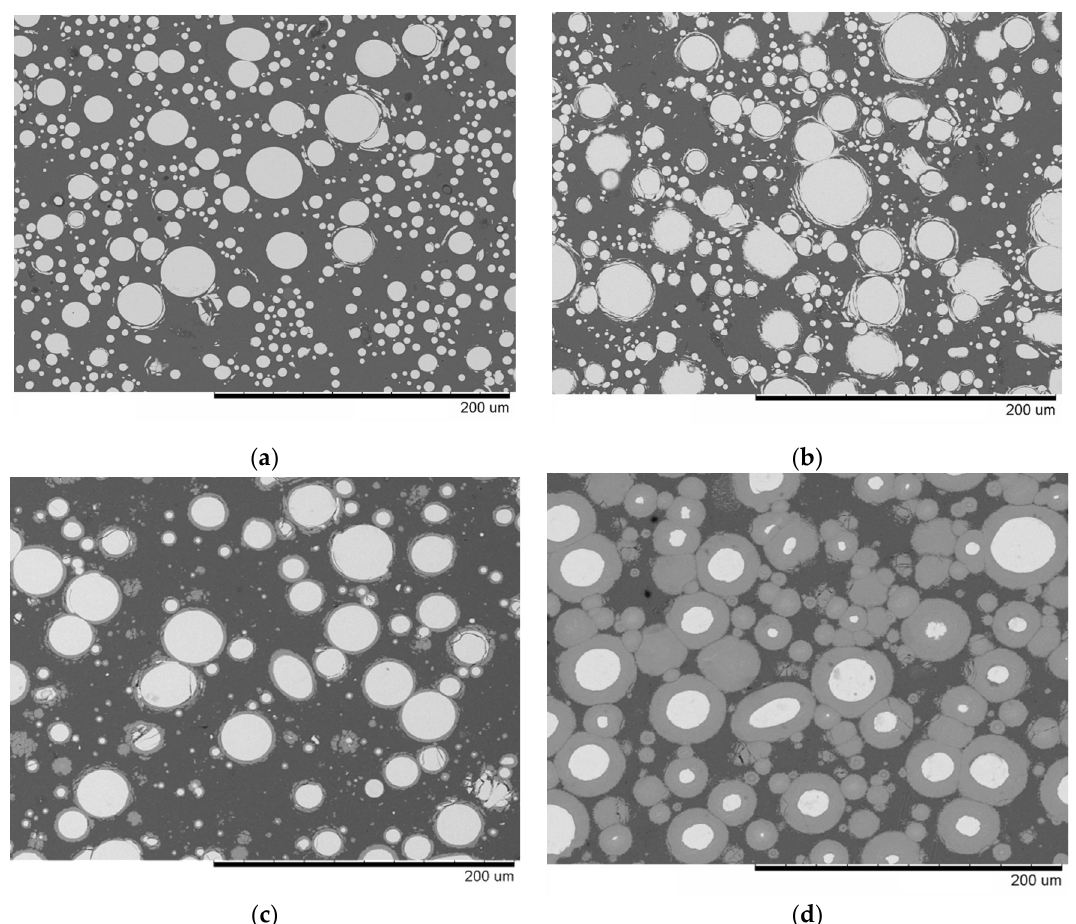
Figure 2. XRD patterns of composites obtained from Al-20 vol.% Fe 66 Cr 10 Nb 5 B 19 mixtures: ( a ) spark plasma sintering (SPS) at 540 °C, no holding, and SPS at 540 °C, no holding/forging at 450 °C; ( b , c ) enlarged portions (30–50°) of the XRD patterns of samples shown in ( a ); ( d ) SPS at 540 °C, 3 min, and SPS at 570 °C, 3 min; ( e , f ) enlarged portions (30–50°) of the XRD patterns of samples shown in ( d ).